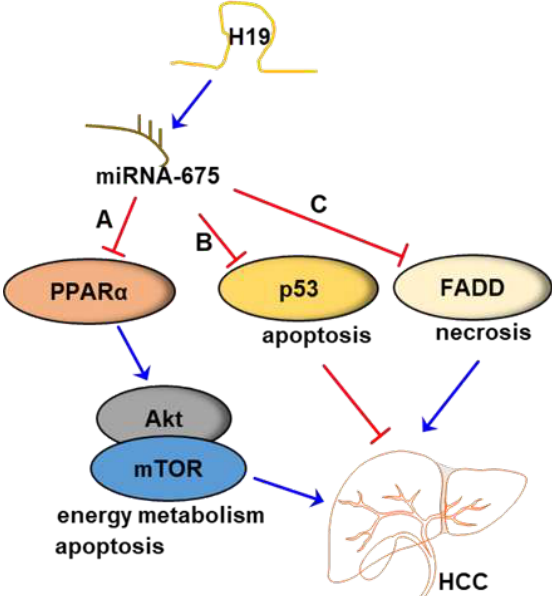
Figure 1. The potential mechanisms of the LncRNA H19/miR-675 axis in HCC. ( A )